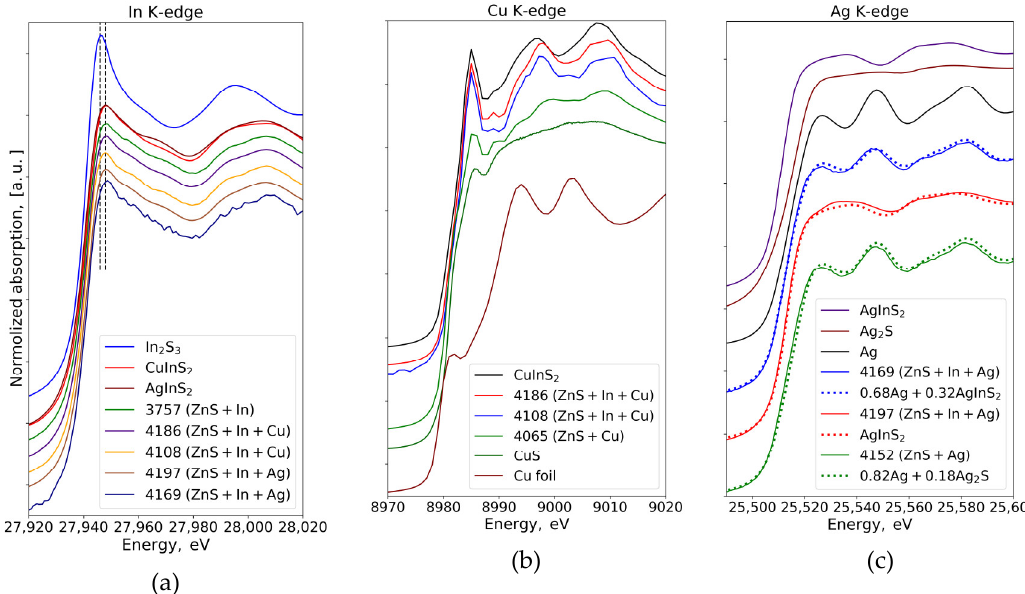
Figure 3. X-ray absorption near edge structure (XANES) spectra of synthetic sphalerites and reference substances: ( a ) In K -edge spectra; ( b ) Cu K -edge spectra; ( c ) Ag K -edge spectra. The qualitative composition of the sphalerite samples and the references are indicated in each figure. Dashed lines in ( a ) indicate the position of white line (WL) for In 2 S 3 (left line) and all other samples and references (right line). Dotted lines in ( c ) show the results of the linear combination fitting (LCF) of the spectra of (In)–Ag–bearing sphalerites; fit results are given in Table S2 of Supplementary Materials and discussed in Section 3.2.3. Table 2. Interatomic distances in the three nearest-to-cation coordination shells (CS) in sphalerite ZnS, roquesite CuInS 2 , and laforetite AgInS 2 according to crystal chemical data.